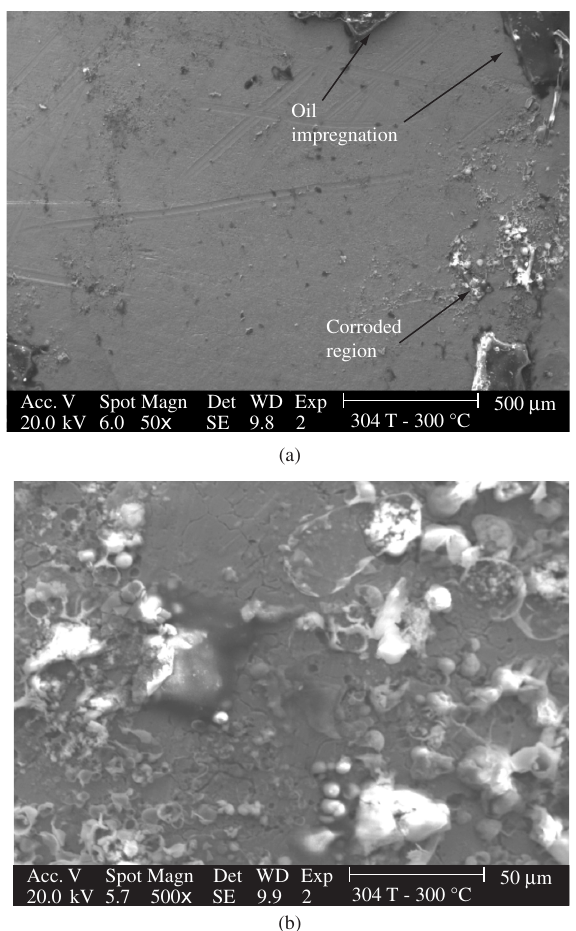
Figure 3. Chemical composition of precipted particles on AISI 304 steel surface obtained by EDX analysis. Sample heat treated from room tempera- ture up to 200 °C.